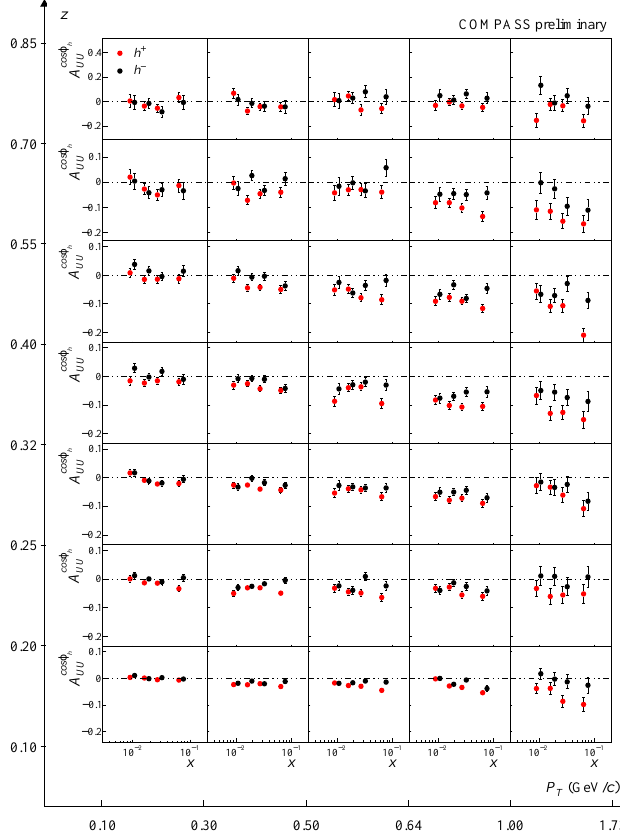
φ h asymmetry for positive (red) and negative hadrons (black), as a Figure 2: A cos UU function of x and in bins of z (vertical axis) and P